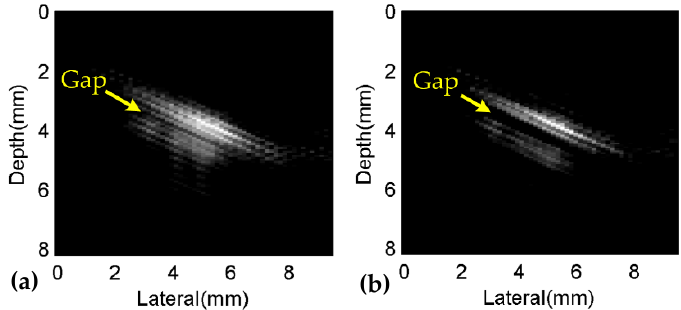
Figure 6. Reconstruction results of the experiment. ( a ) the reconstructed image of original signal; ( b ) the reconstructed image of processed signal.